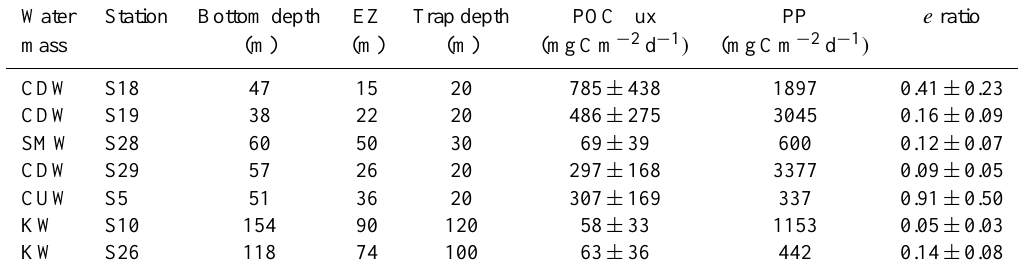
Table 5. Data of corrected POC flux (POC flux), primary production (PP) and e ratio (POC flux/PP) in the ECS. Water Station Bottom